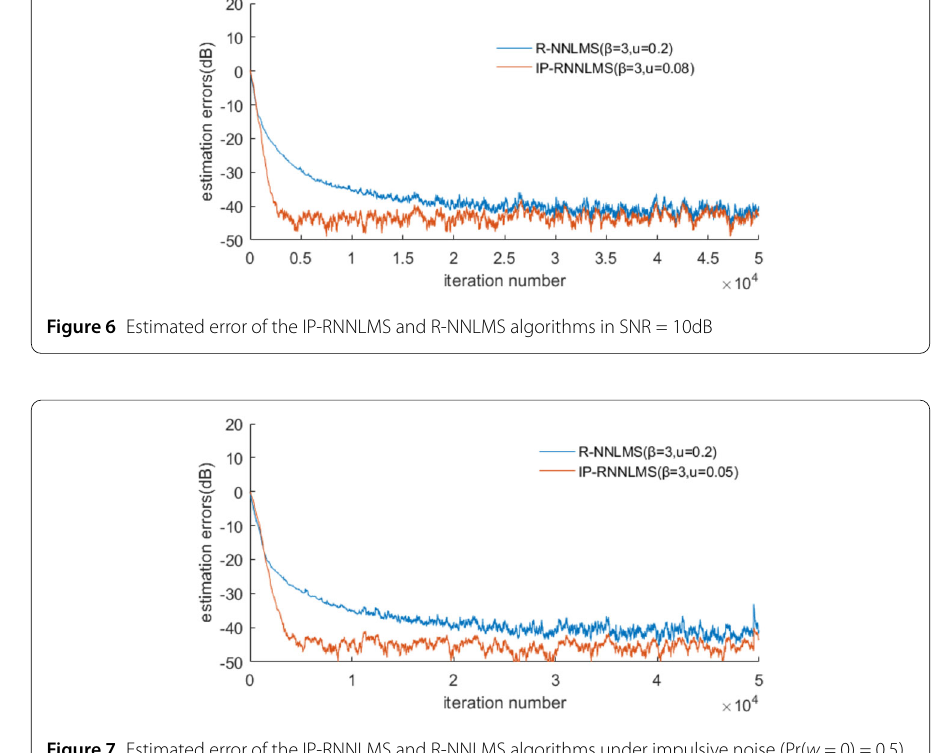
spare system identification. The performance analysis of the proposed algorithm and the research in practical applications will be carried out in future